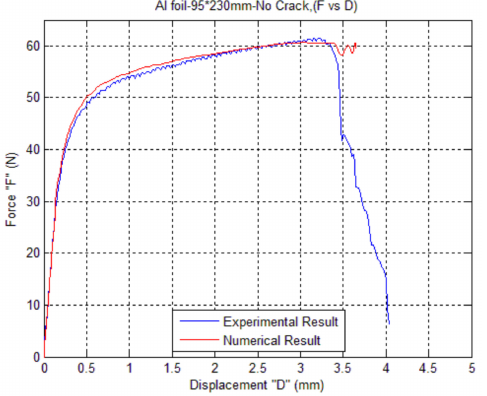
Figure 14. Force vs. displacement graph of aluminum foil (No Crack).